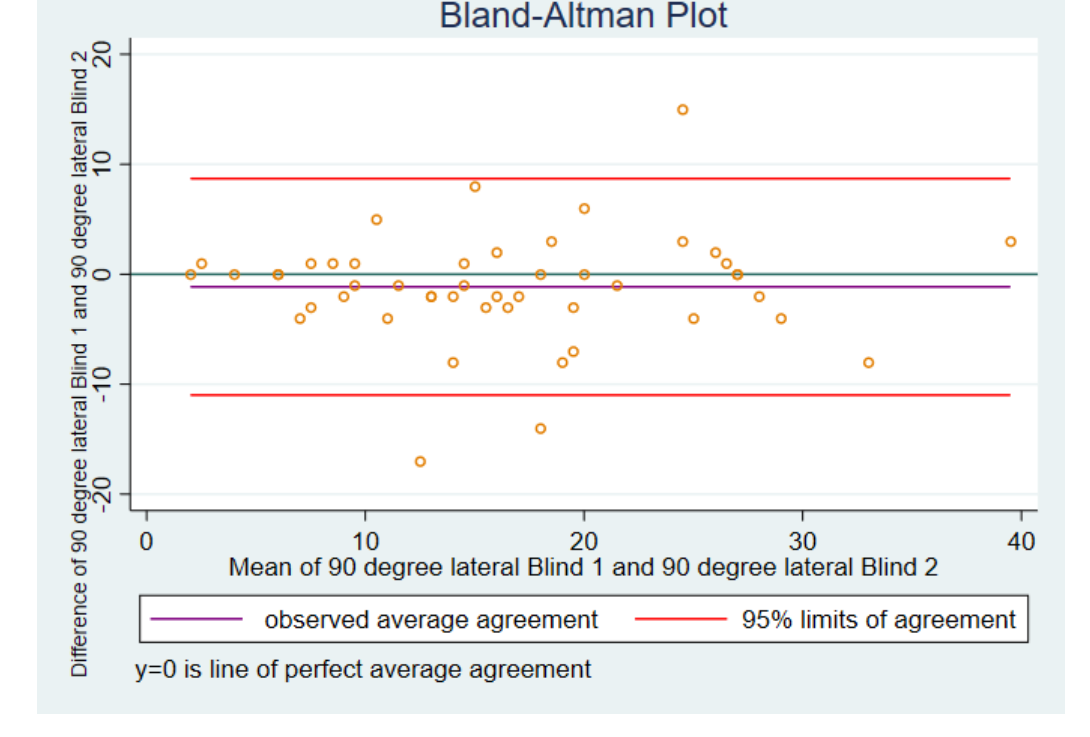
Figure A3. Ninety degrees, lateral.